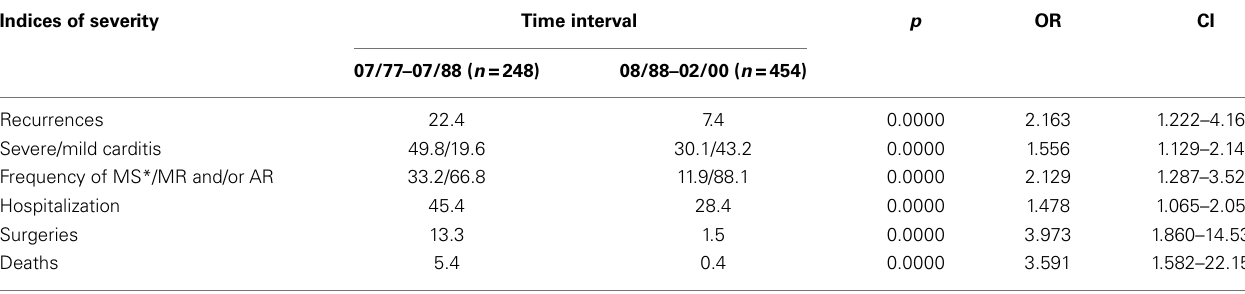
Table 4 | Comparative analysis of frequency of recurrences and indices of severity